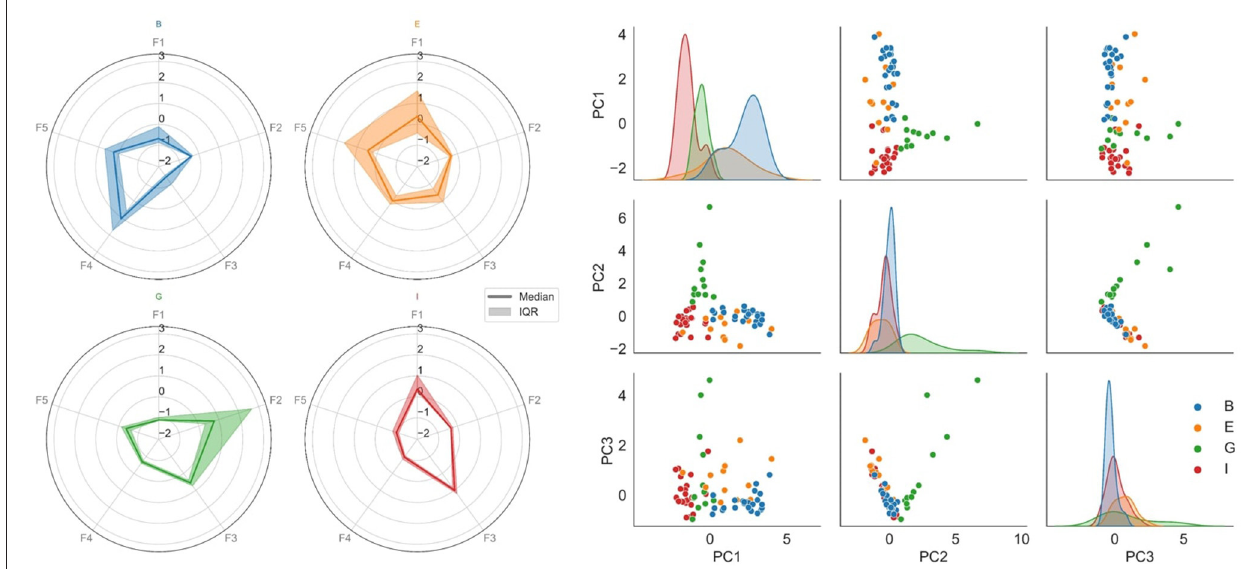
FIGURE 2 | The multimodal ictal fingerprint. Each color represents a separate participant (blue, orange, green, and red are person B, E, G, and I, respectively). Left: Radar charts of the ictal feature medians and interquartile ranges for each person. F1: X-axis acceleration component; F2: EMG power proximal; F3: EEG relative delta power; F4: EEG relative low theta power; F5: EEG relative high theta power. The heterogeneity across persons is shown. The ictal fingerprint of person B (blue) is dominated by EEG theta power elevation. The fingerprint of person E (orange) has a partial overlap with elevated theta activity. However, the movement component (F1) is a major contributor for this fingerprint. The movement component is also substantial for person I (red), but with no remarkable theta elevation. The ictal fingerprint of person G (green) is not dominated by either of the mentioned features; instead, elevated EMG activity is the main contributor. Right: Pair plot of the first three principal components of the reduced feature space of the ictal periods, where each dot represents a seizure. Scatterplots are shown for each pairing of the principal components, and marginal distributions are plotted along the diagonal (layered kernel density estimates). Within-person clustering and separation across persons are shown. The seizures of each individual could be separated from the rest with an 84.5%